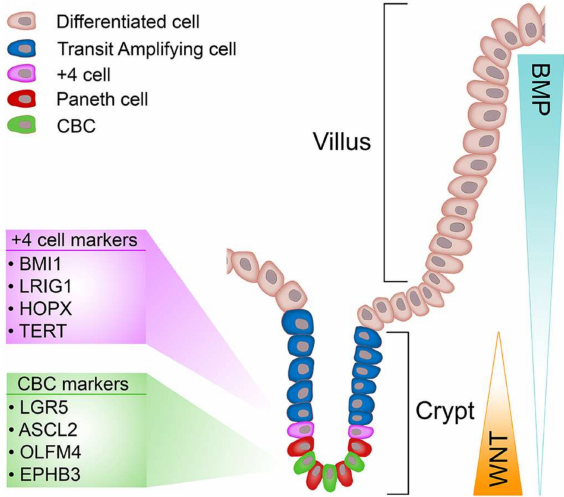
Figure 1. Stem cell populations and signalling gradients of the gastrointestinal epithelium. Schematic of the small intestinal epithelium depicting the various cell types, stem cell populations and signalling